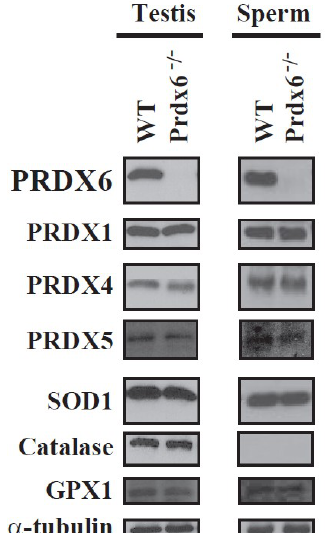
Figure 1. Expression of antioxidant enzymes in wild-type and Prdx6 − / − testis and spermatozoa. No compensatory mechanisms by overexpression of other antioxidant enzymes were observed due to the absence of peroxiredoxin 6 (PRDX6) in testes or spermatozoa. Sodium dodecyl sulfate polyacrylamide gel electrophoresis (SDS-PAGE) and immunoblotting of different antioxidant enzymes in C57Bl6J wild-type (WT) or Prdx6 − / − testis and spermatozoa were done as before [12,15]. α -tubulin was used as loading control ( n = 4). SOD1: superoxide dismutase 1; GPX1: glutathione peroxidase 1.